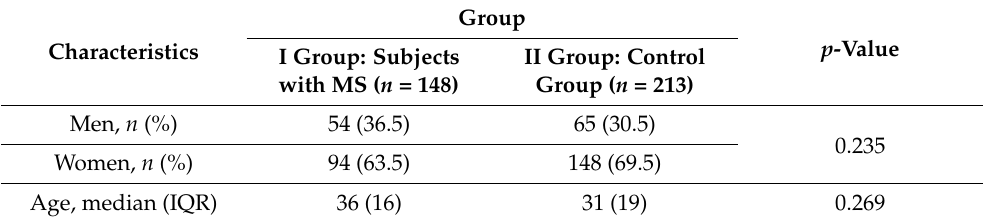
Table 1. Characteristics of study subjects.